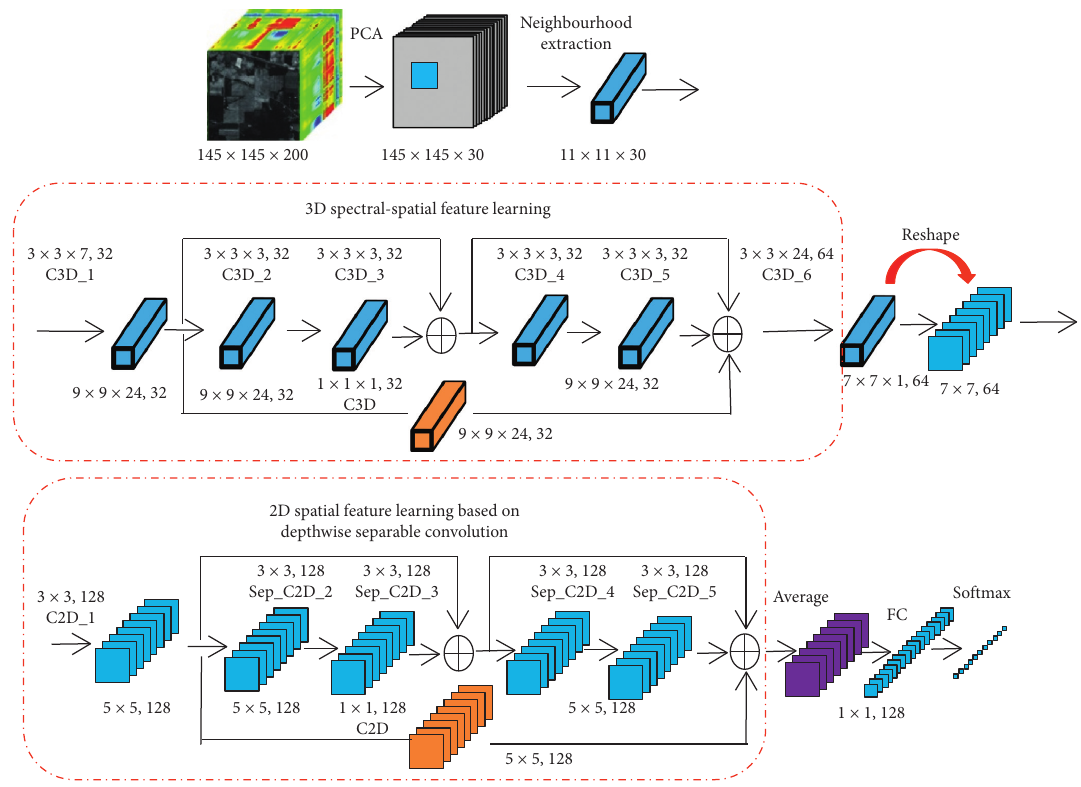
Figure 1: The HDSRN classification